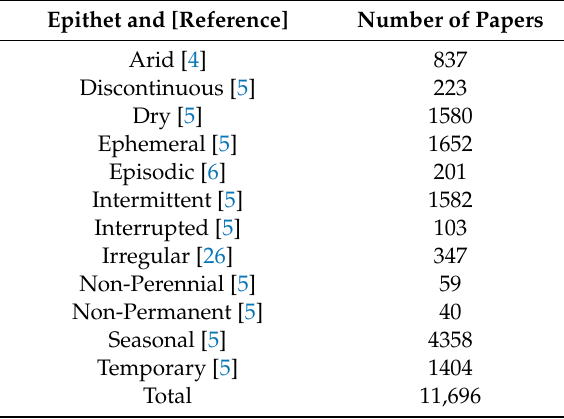
Table 1. Table of search results from Web of Science. Epithets used to define non-perennial systems in the present study, paired with the source it was pulled from in brackets. We limited our search results by WoS categories to narrow our results for papers specifically related to natural river systems. Epithet and [Reference] Number of Papers Arid [4] 837 Discontinuous [5] 223 Dry [5] 1580 Ephemeral [5] 1652 Episodic [6] 201 Intermittent [5]